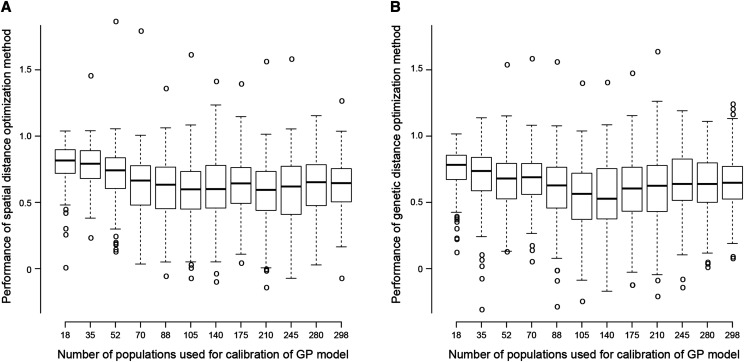
Performance of the (a) spatial and (b) genetic distances optimization methods for choosing the populations to be included in the calibration set to build a genomic prediction model against the number of populations included in the calibration set. The boxplots represent the variability of the performance between the different traits. In order to calculate the performance of an optimized calibration set, the minimum (MinPA) and maximum (MaxPA) predictive abilities over 100 randomly selected calibration sets of same size were computed. The performance of an optimized calibration set was then calculated as OptPA−MinPAMaxPA−MinPA with OptPA being the predictive ability obtained with the optimized calibration set. All available SNP markers were included in prediction models.